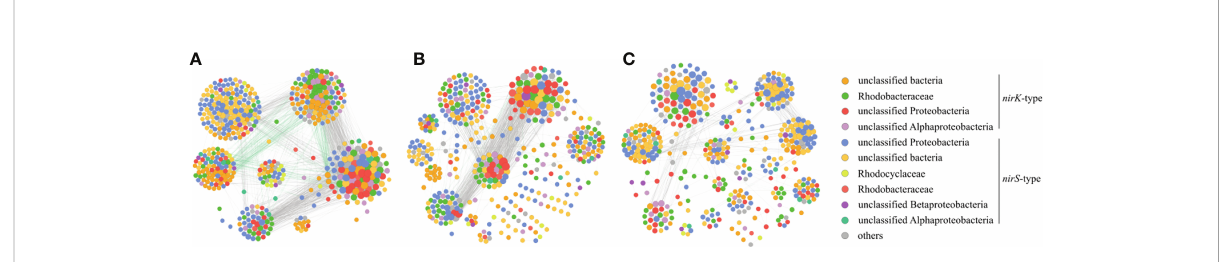
FIGURE 7 Co-occurrence networks of the denitrifying bacteria during the green tide (A) , the outbreak phase (B) and the decline phase (C) in coastal Qingdao